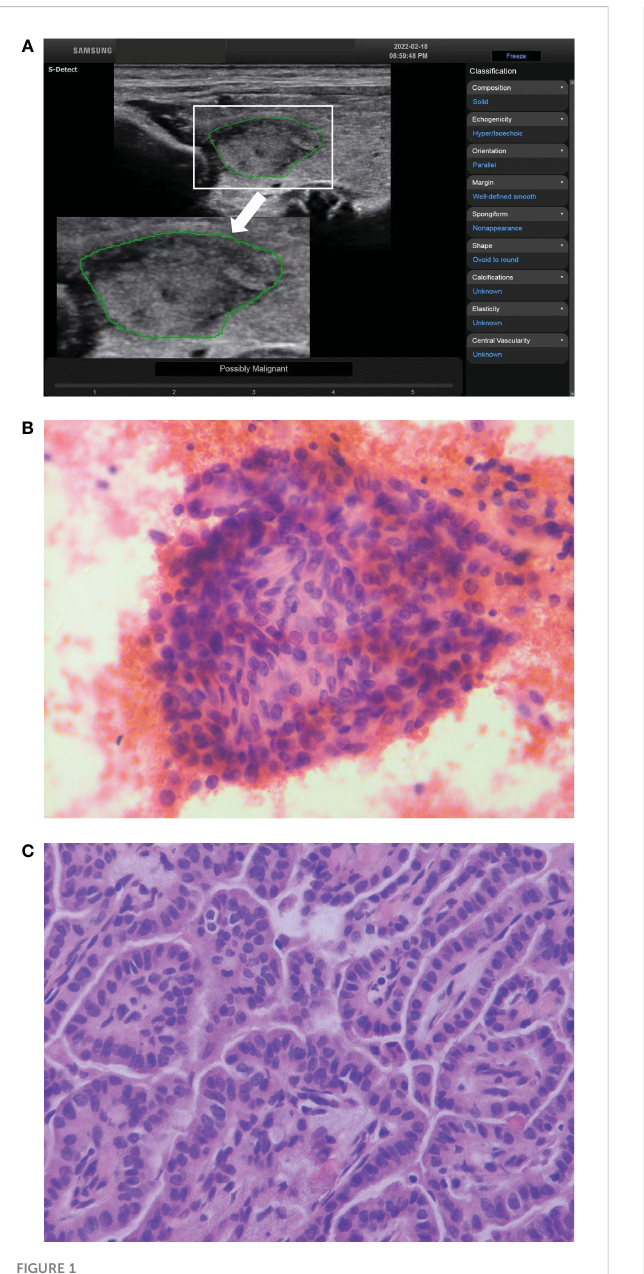
FIGURE 1 The ultrasound features of a thyroid nodule in a 28-year-old woman were solid, hypoechoic, wider than tall, smooth margin and without echogenic foci. S-Detect indicated “ Possibly Malignant ” (A) . The ACR TI-RADS was TR4 with 4 points, and the C-TIRADS was TR4A with 1 point. It was considered to be a benign nodule. The nodule was classi fi ed as Bethesda V category after fi ne-needle aspiration (B) (HE staining; magni fi cation ×400). And the fi nal pathological result showed papillary thyroid carcinoma (C) (HE staining; magni fi cation ×400).